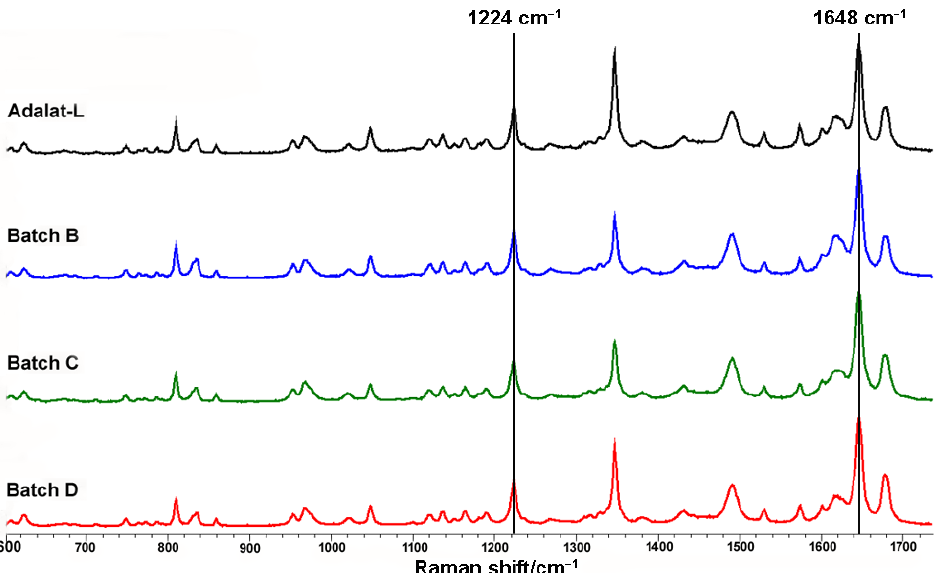
Figure 4. Comparison of crystalline forms of sustained-release nifedipine